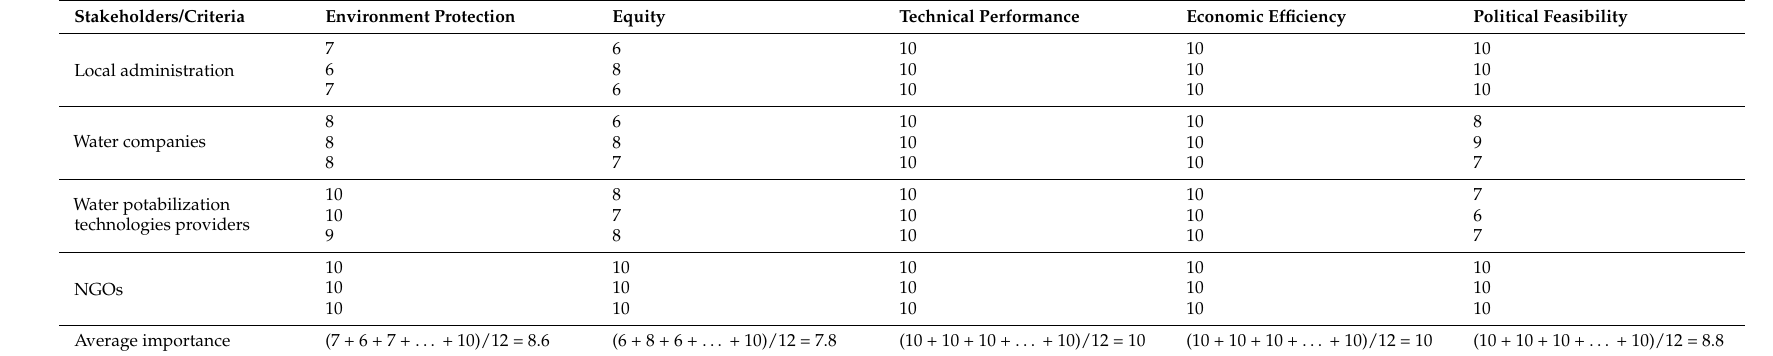
Table 5. Importance of criteria (as assigned by